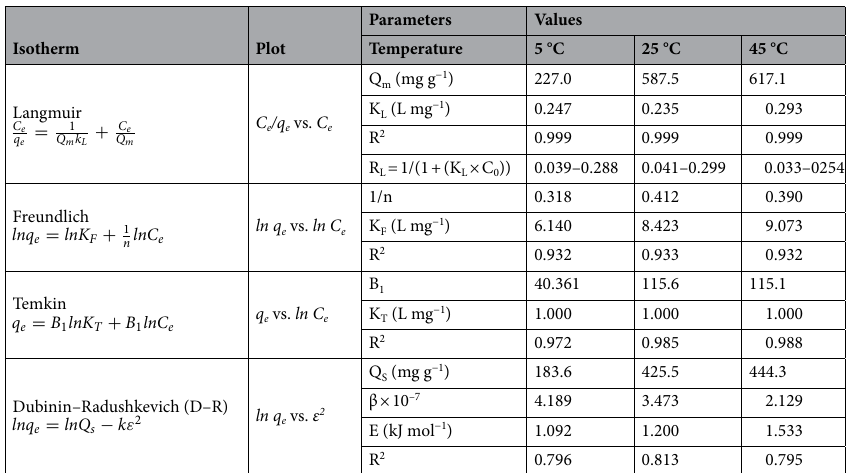
Parameters Values